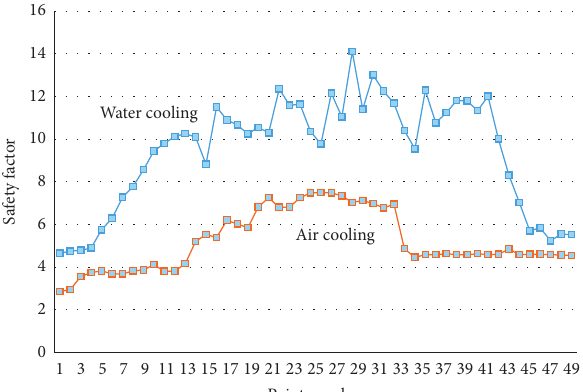
Figure 8: Safety coefficient curve of the water-cooled part.